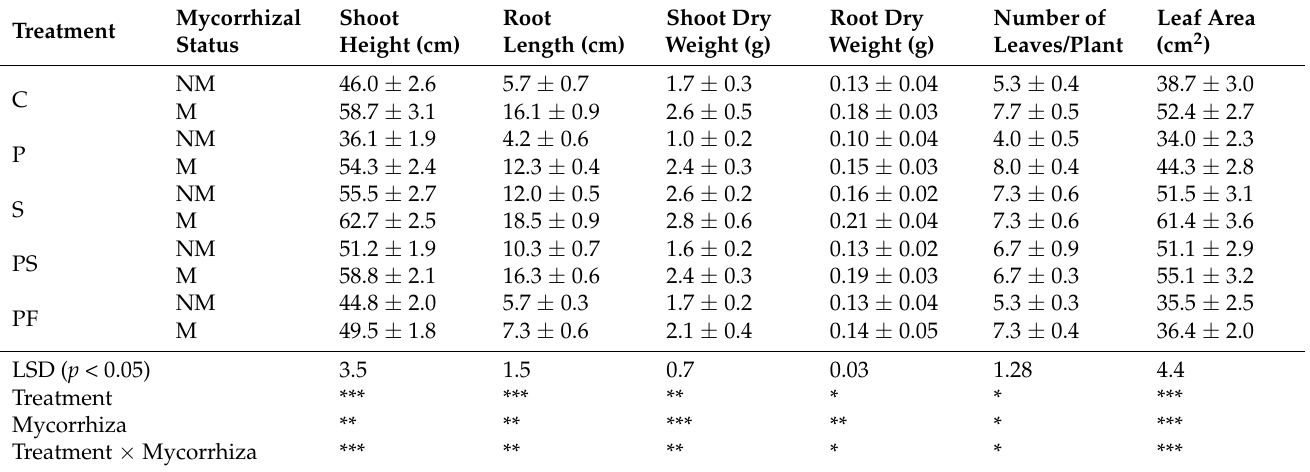
Table 3. Effects of application of S. viridosporus HH1 and/or colonization with R. irregularis on